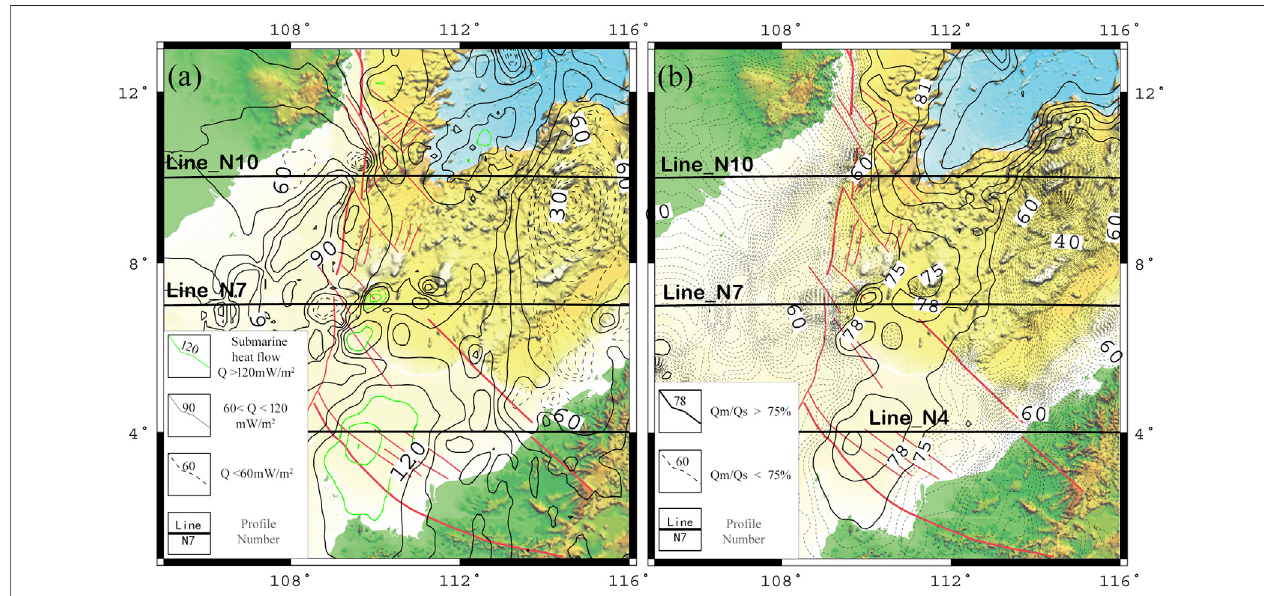
FIGURE 3 | Contour maps of the submarine heat fl ow and the Q m / Q s heat fl ow structure in the southwestern margin of South China Sea. (A) Submarine heat fl ow Q s : mW/m 2 . (B) Q m / Q s :